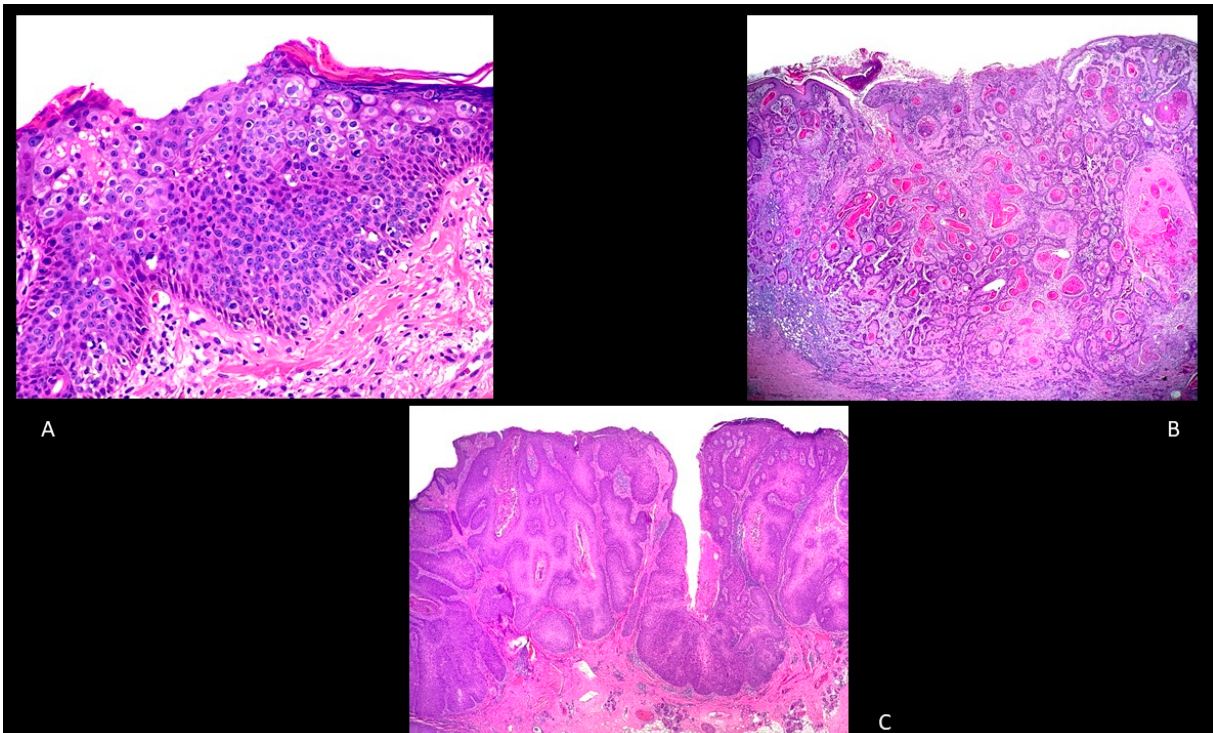
Figure 2. ( A ) : Bowen’s disease. Hematoxylin and Eosin, 100× ( B ): Well-differentiated, invasive squamous cell carcinoma, hematoxylin and eosin, 20×. ( C ): Verrucous squamous cell carcinoma, hematoxylin and eosin, 20×.